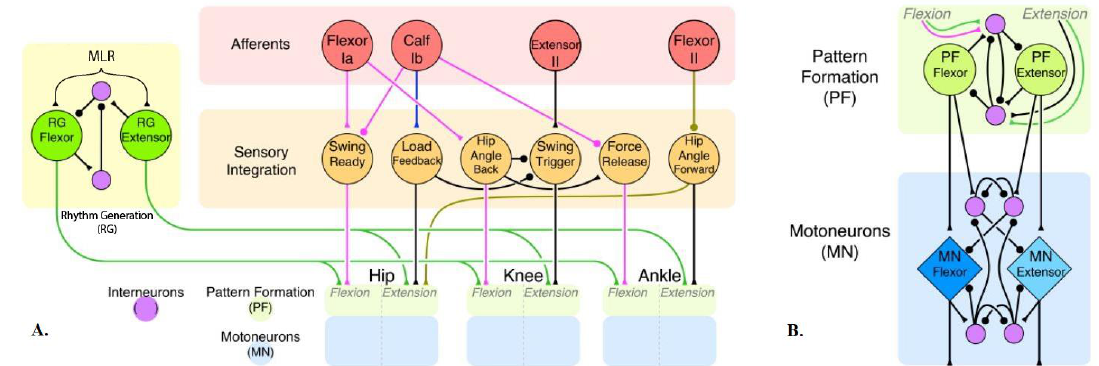
Figure 2. ( A ) Hypothetical synthetic nervous system for a single limb. ( B ) Limb joint control network that forms active pattern of motoneurons. Coordinating pathways are inhibitory (filled circles) or excitatory (filled triangles). Pathways inspired by biological research are indicated by colored synapses of magenta, blue, and brown [26]. Hypothesized pathways are in black. MLR: Midbrain locomotor region.